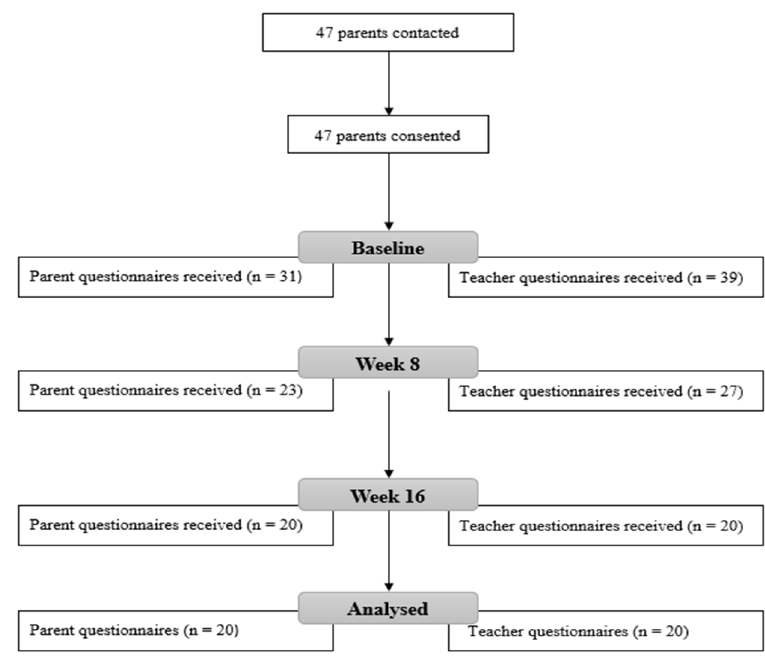
Figure 1. Process of gathering data.